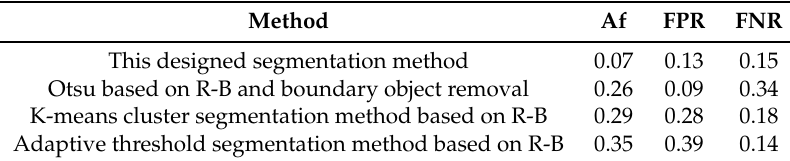
Table 4. Evaluation index statistics of different segmentation